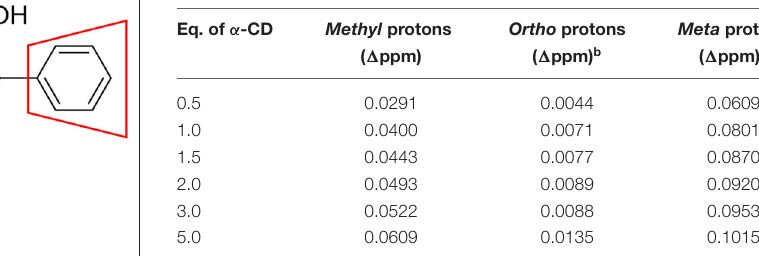
TABLE 3 | Changes in the 1 H NMR spectral signals of protons on bisphenol A as a function of added equivalents of α -cyclodextrin ( α -CD) a